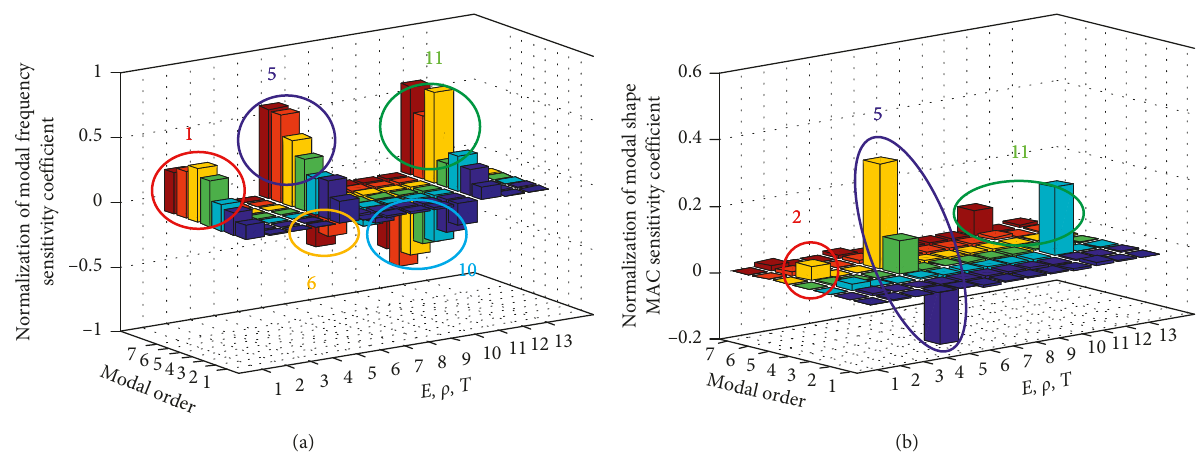
Figure 11: Sensitivity of the design parameters. (a) Sensitivity of modal frequency to design variables. (b) Sensitivity of modal shape MAC values to design